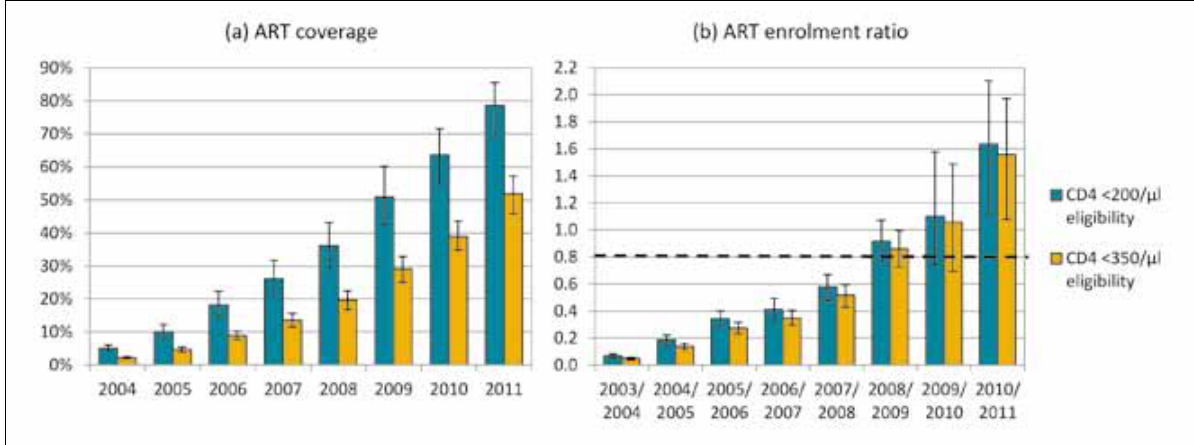
Fig. 3. Adult ART access. Bars represent posterior means and error bars represent 95% confidence intervals. Dashed line in panel (b) represents 2007 - 2011 National Strategic Plan